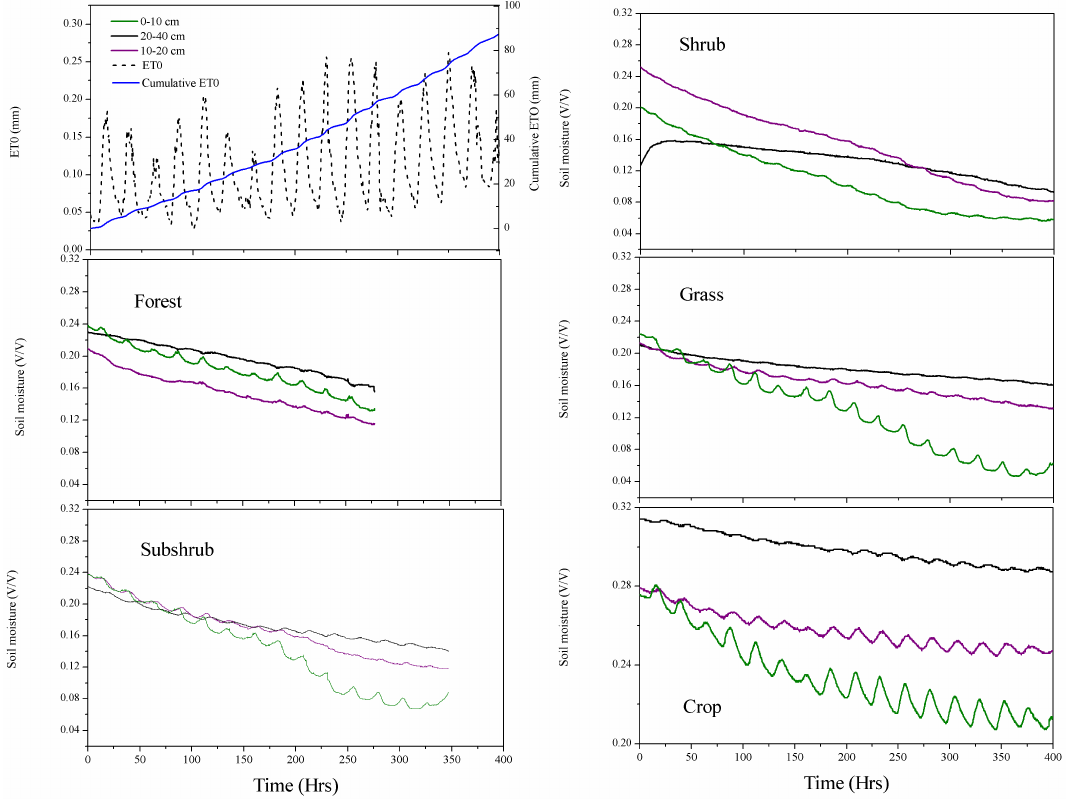
Fig. 6. Soil moisture decrease process under the five land cover types from 31 July to 15 August. Table 2. The comparisons of average soil moisture between the five land cover